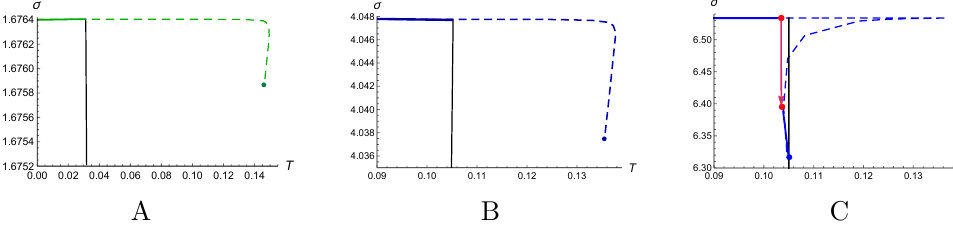
Figure 19 . String tension as function of temperature for z 0 = 0 , µ = 0 . 5 , ν = 1 (A) and z 0 = 0 . 1 , µ = 0 . 5 , ν = 4 . 5 , longitudinal (B) and traversal (C); a = 4 . 046 , b = 0 . 01613 , c = 0 . 227 . Solid lines — the realized values of string tension; dotted line (A) — the WL phase transition; black solid lines (B,C) — BH-BH phase transition; dashed blue lines — string tension for temperature higher than the temperature of BH-BH phase transition, T > T BH − BH , i.e. string tensions in unstable phase. In the transversal (C) case the string tension is three-valued function and the string tension has phase transition that happens for less temperatures than the temperature of BH-BH phase transition. Red arrow shows jumps of the string